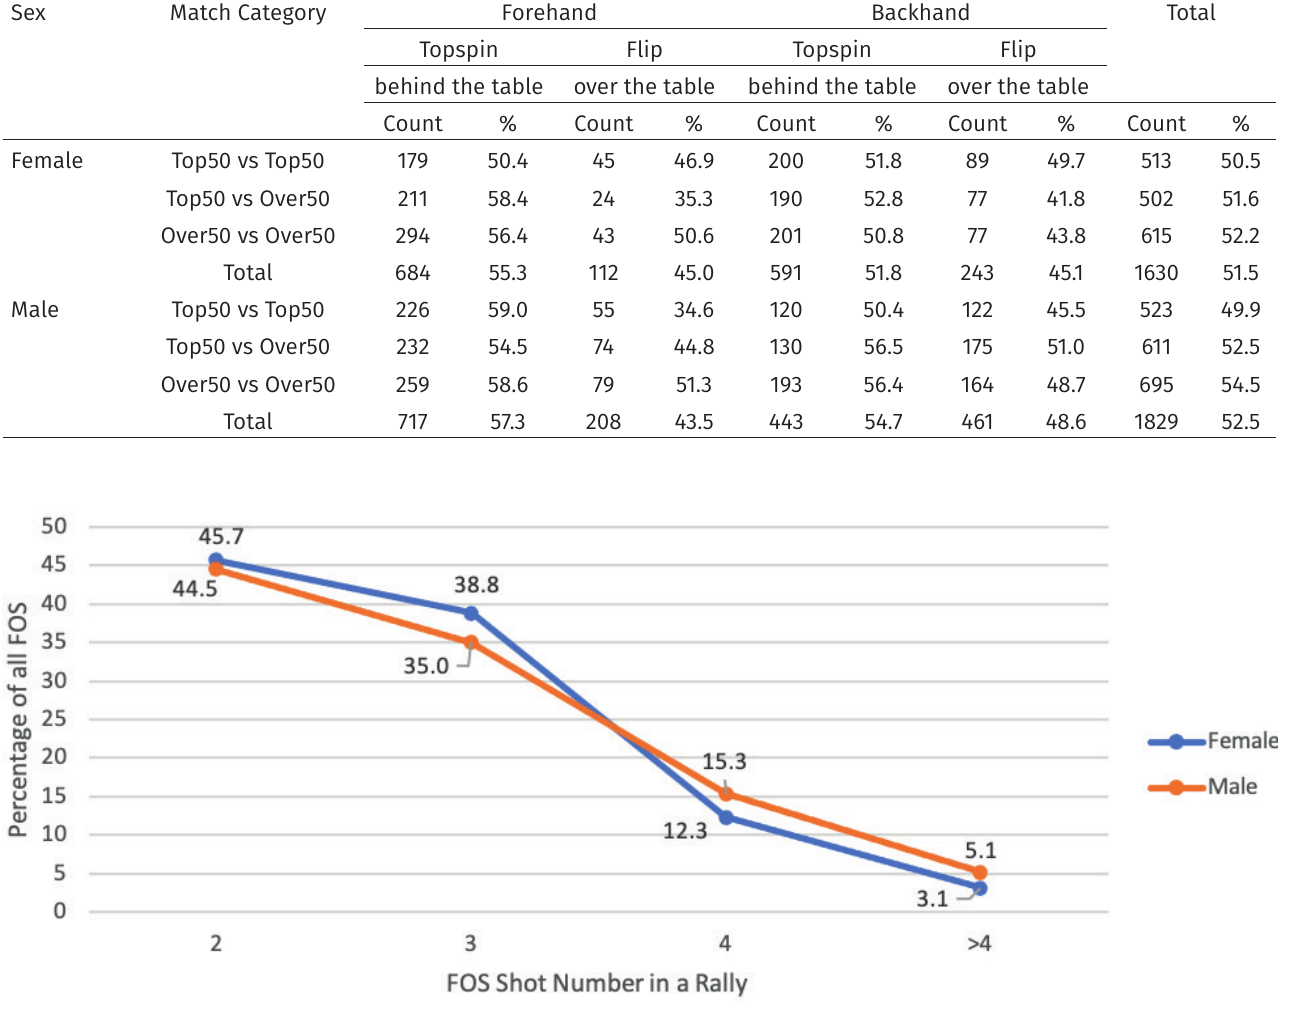
Figure 2. Distribution of the FOS Shot Number in a Rally.